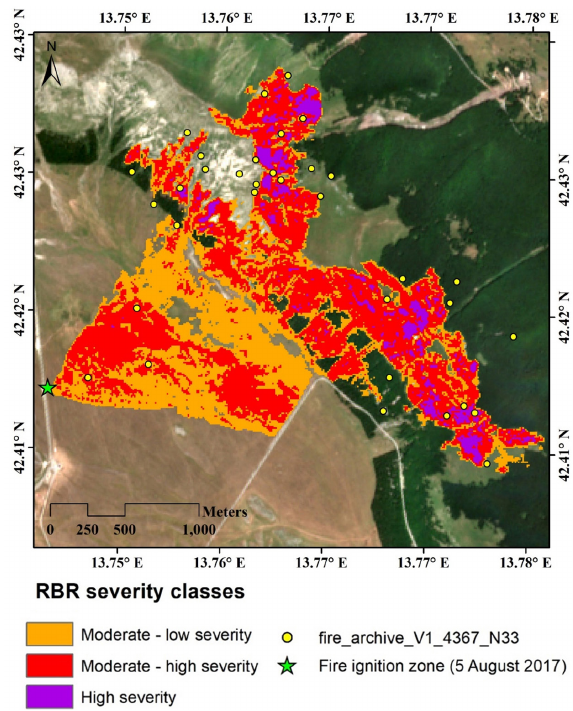
Figure 2. Relativized Burn Ratio (RBR) for the study area. The index has been discretized in three ‘burn severity’ classes (Mod- erate-Low, Moderate-High and High severity). The validation points (VIIRS) are marked in yellow, while the point where the 2017 fire was triggered is indicated with green star.